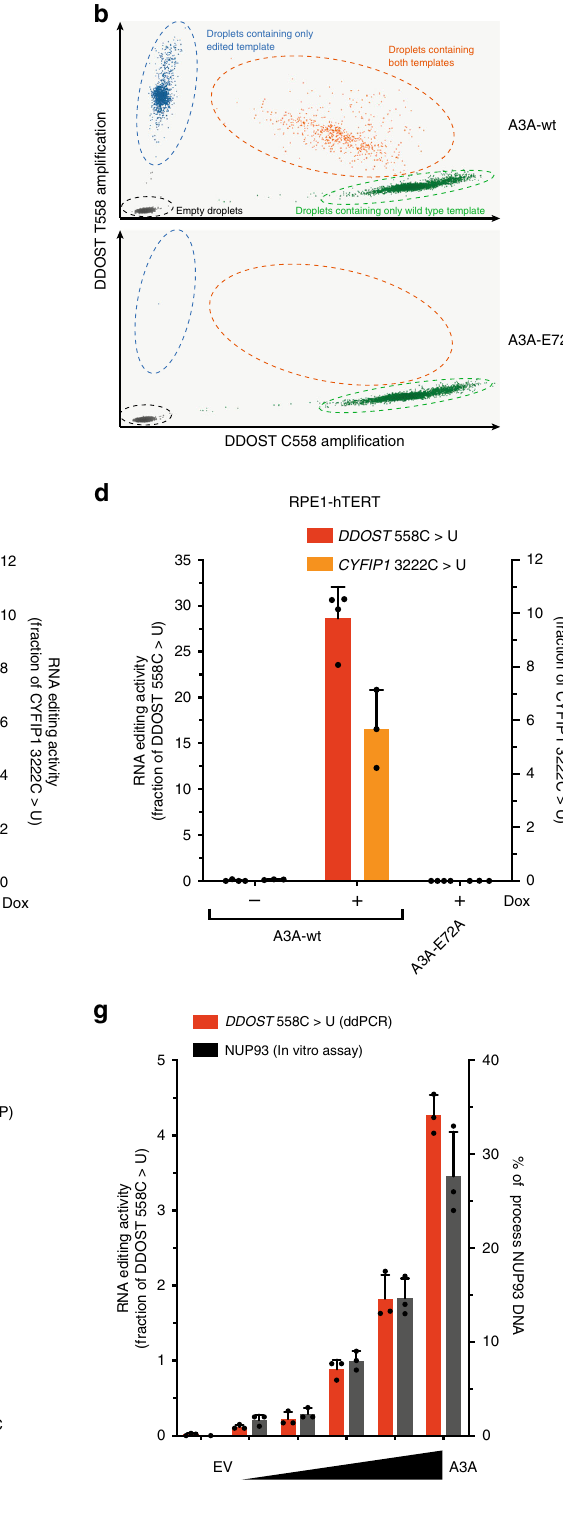
(Supplementary Fig. 9A). Two days after A3A induction, total RNA is isolated, retrotranscribed to DNA, and then analyzed by ddPCR (Fig. 4a). To detect A3A-mediated RNA editing, we selected DDOST 558C>U and CYPIF1 3222C>U , the two most frequent RNA hotspot mutations in A3A + tumors, as targets for ddPCR (Fig. 3b, c). Both the DDOST 558C>U and CYPIF1 3222C>U mutations occur